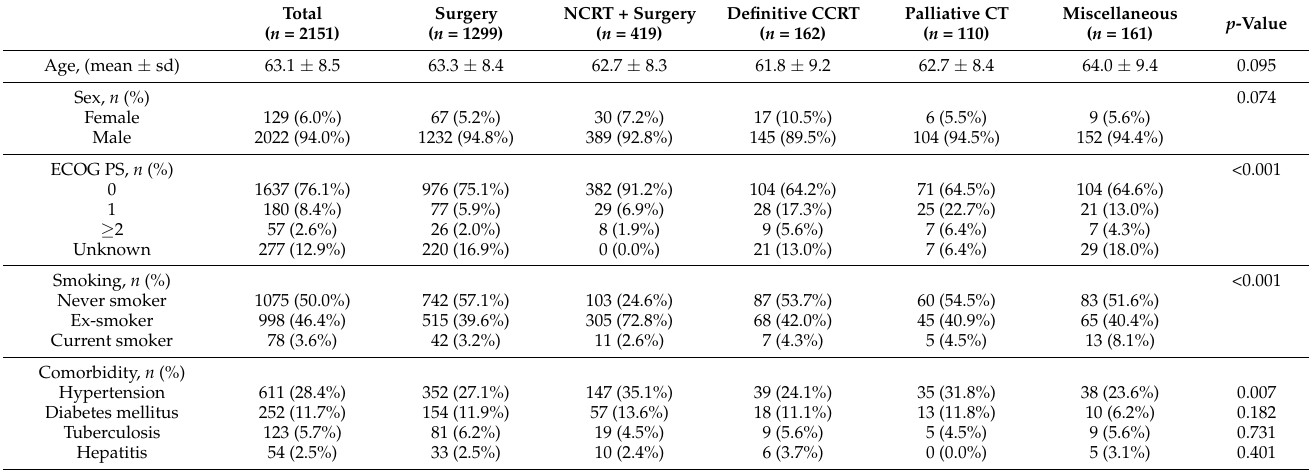
Table 1. Characteristics of participants.